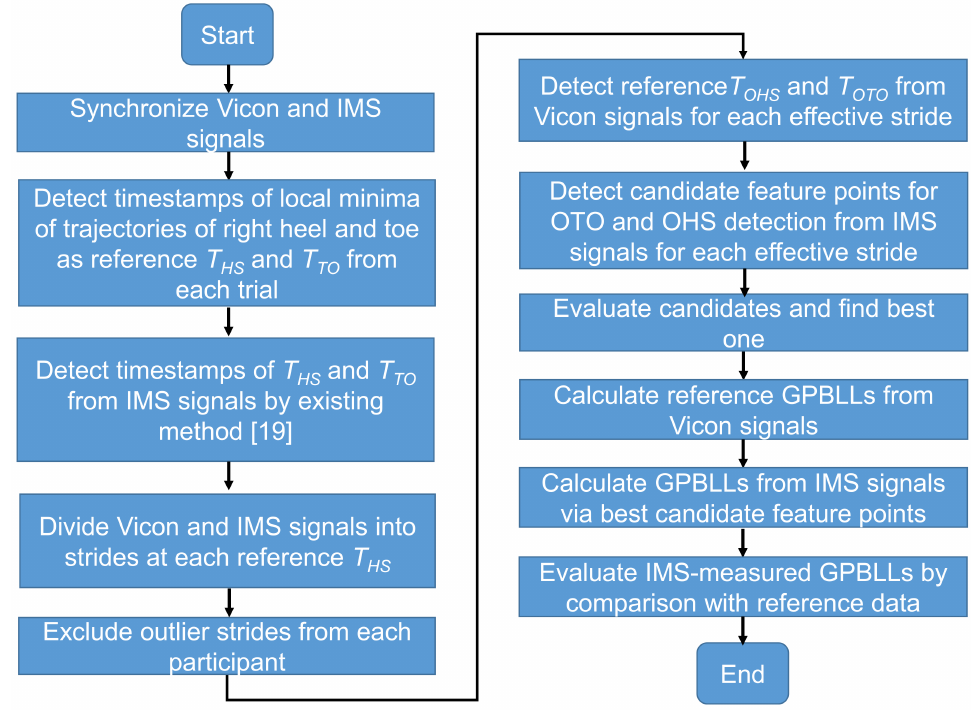
Figure 4. Flowchart of the signal processing procedure in this